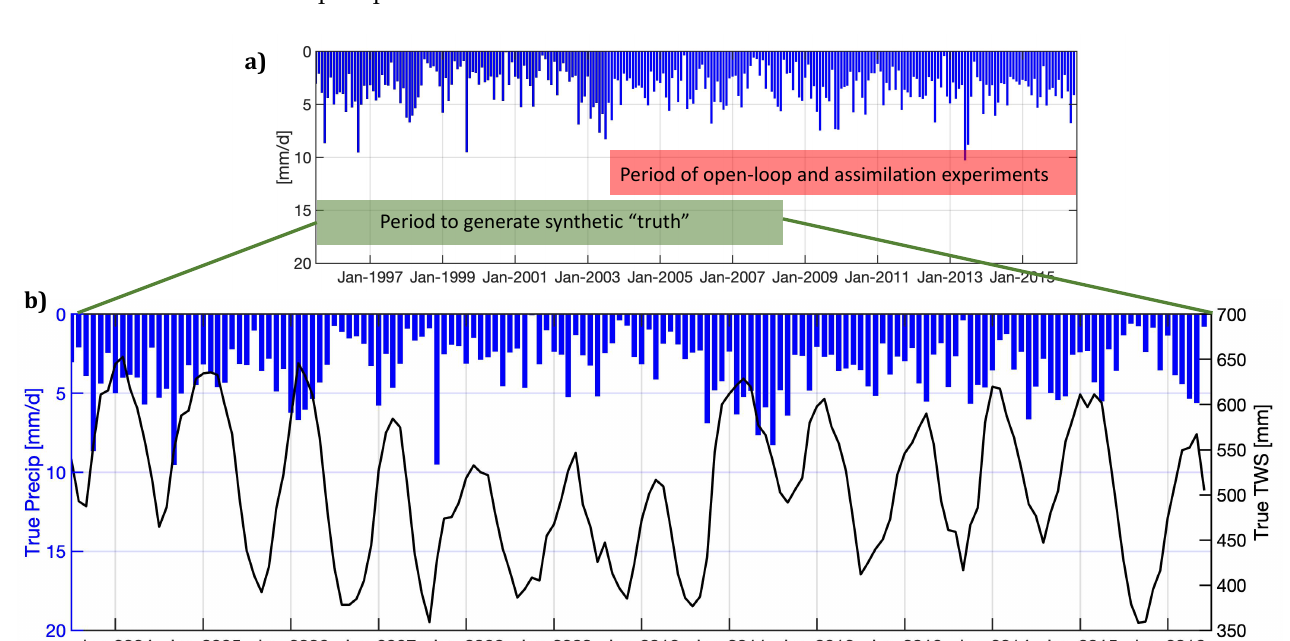
Figure 1. ( a ) MERRA-2 precipitation from July 1995 to July 2016. The green and red horizontal bars indicate the periods to (i) generate synthetic precipitation (July 1995–July 2008) and (ii) evaluate model and assimilation results (July 2003–July 2016), respectively. ( b ) Synthetically generated precipitation (blue bars) and synthetic Terrestrial Water Storage (TWS, black line) for the period of analysis (July 2003–July 2016) of a sample 36-km model grid located in Virginia, United States (37.32 N, 78.46